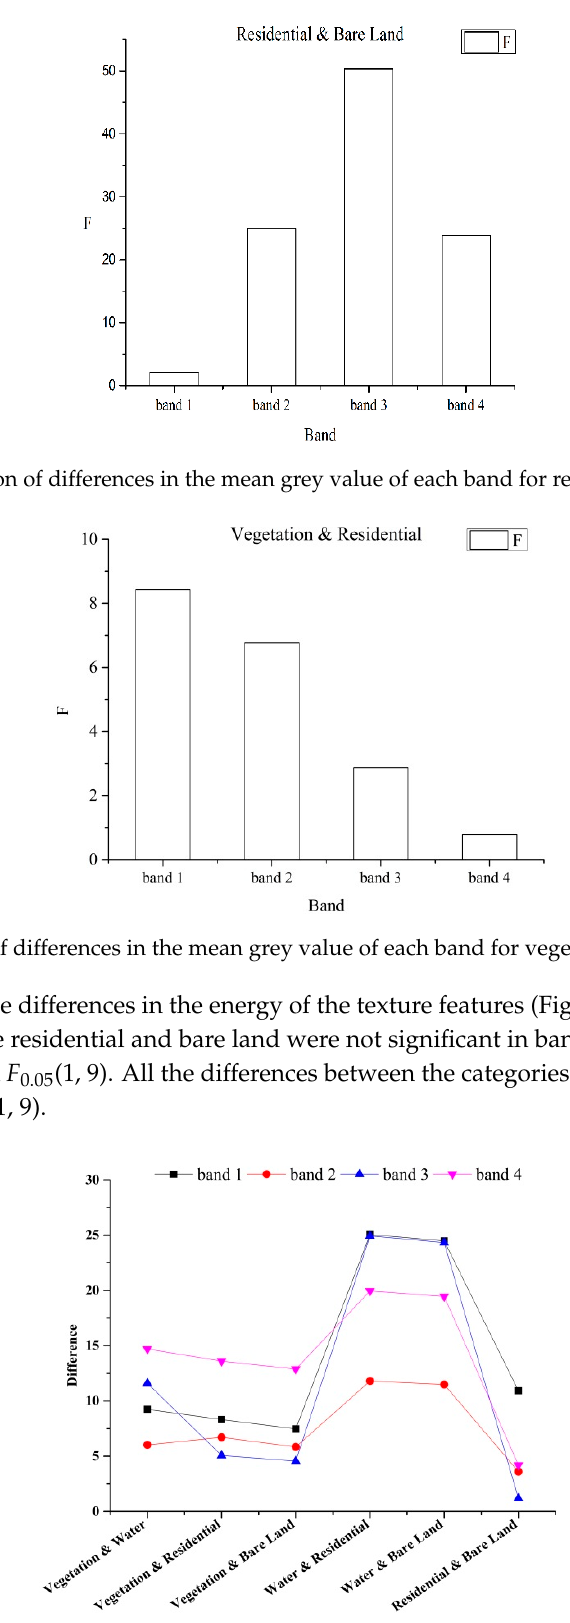
Figure 10. Comparison of the differences in the energy of texture feature energy differences.